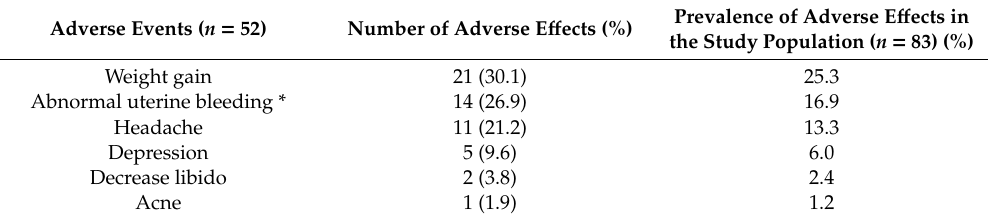
Table 4. Adverse events (any grade) experienced during the